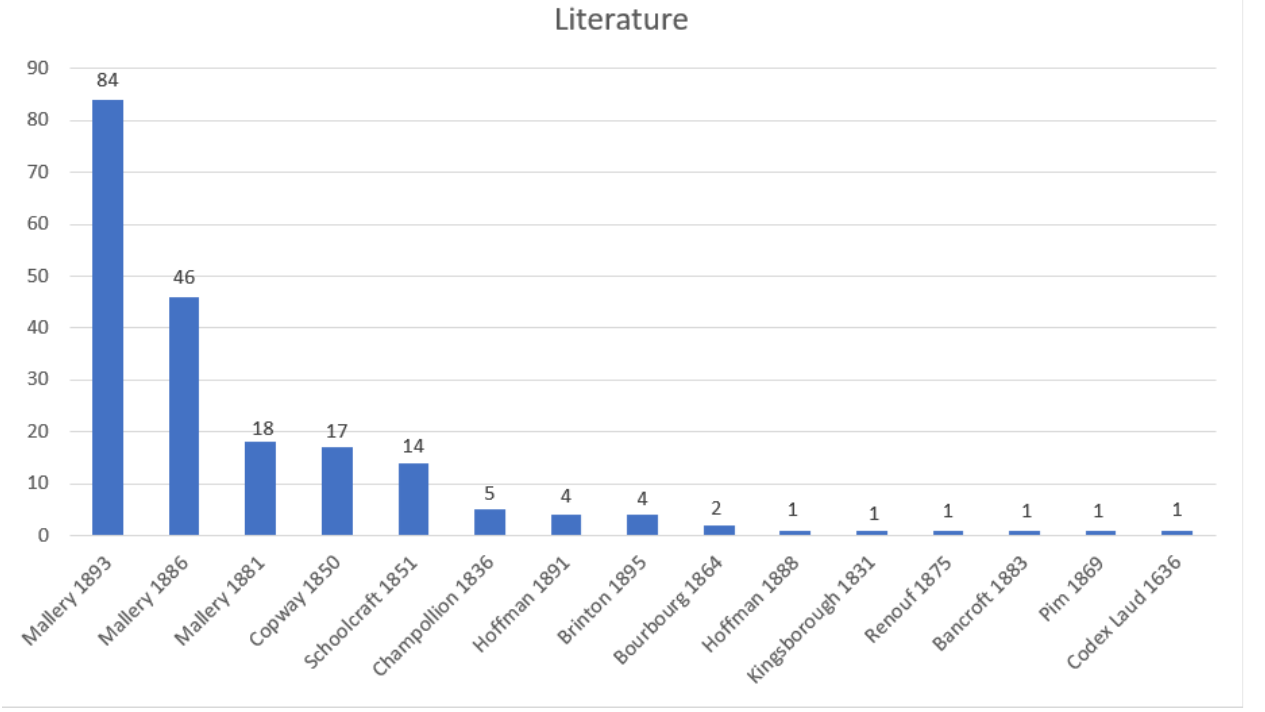
Figure 22. 19th Century sources for WMP imagery (Mallery 1881, 1886, 1893; Copway 1850; Schoolcraft 1851; Champollion 1836; Hoffman 1888, 1891; Brinton 1895; de Bourbourg and Éntienne 1864; Kingsborough 1831–1848; Renouf 1875; Bancroft 1883; Pim and Seemann 1869; Codex Laud 1636).